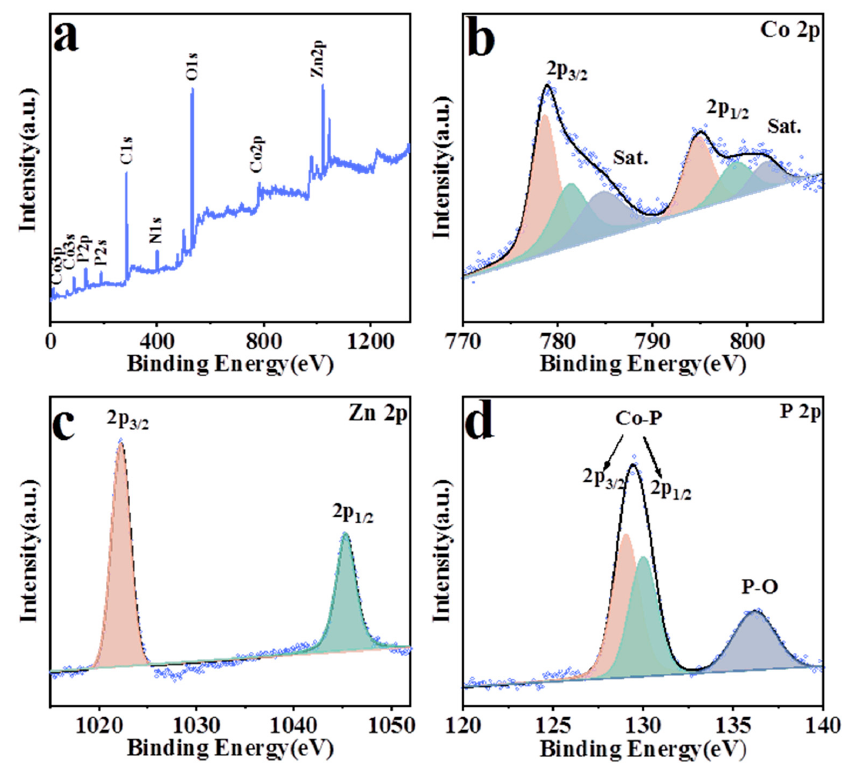
Figure 7. XPS spectra of CoP@ZIF-8. ( a ) Full scan XPS survey; high-resolution XPS signals of ( b ) Co 2p; ( c ) Zn 2p; ( d ) P